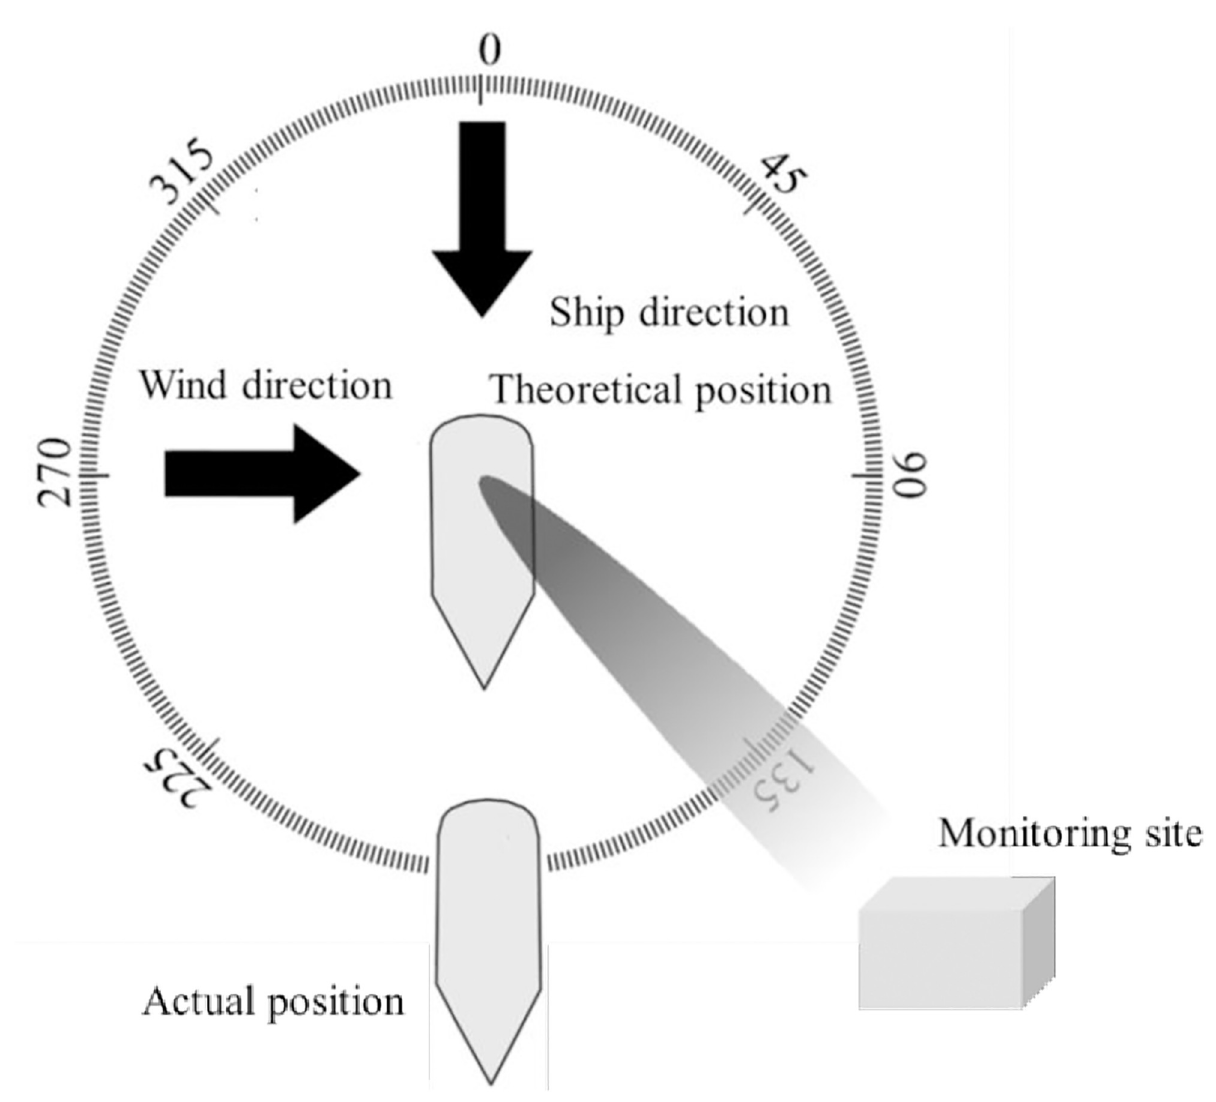
Fig 3. Schematic principle of the second source identification process(the shadow represent the distribution of the ship plumes).